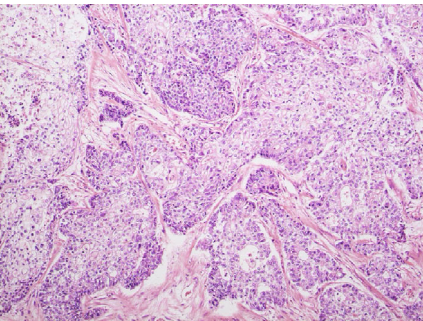
Figure 2: Adenocarcinoma partially shows squamous metaplasia, and components that developed in a sheet-like form are shifting to increased grade of endometrioid carcinoma. Hematoxylin and eosin staining x100.